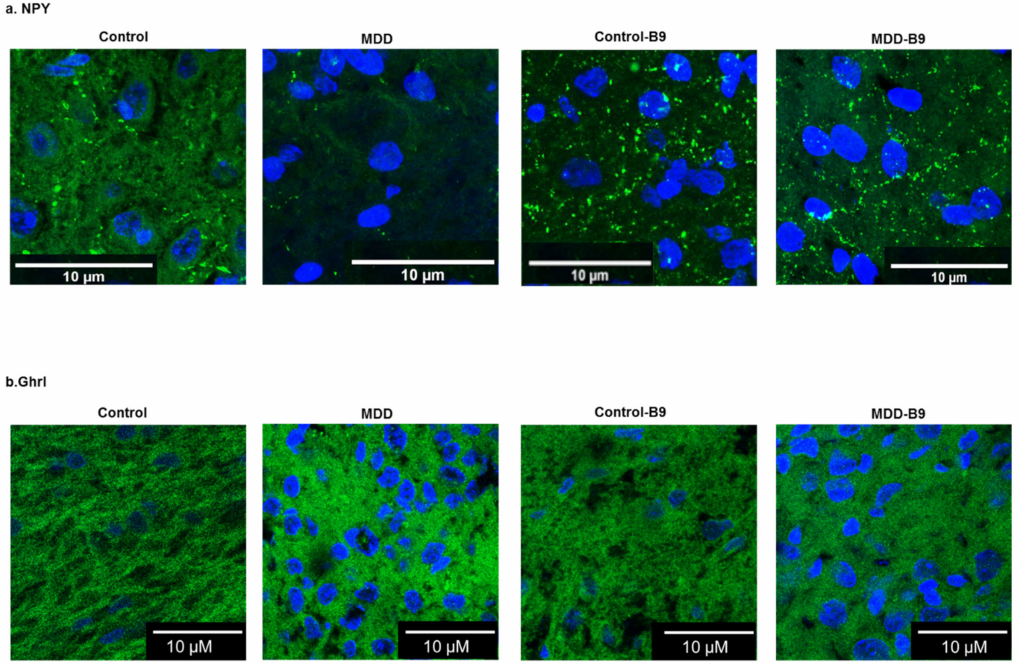
Figure 6. E ff ects of methyl donor deficiency and folate supplementation on the immunohistochemical expression of neuropeptide Y and ghrelin in the arcuate nucleus of the hypothalamus of control and deficient (MDD) rat pups at 21 days. ( a ) Neuropeptide Y (NPY); ( b ) ghrelin (Ghrl). Cell nuclei are counterstained by